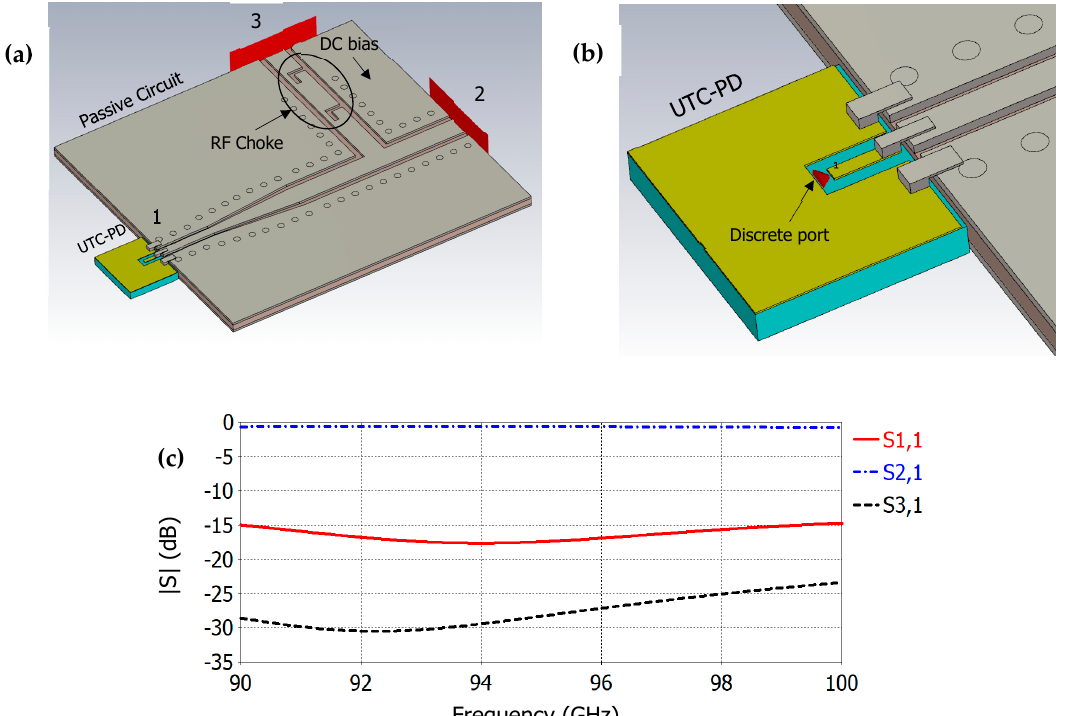
Figure 2. ( a ) 3D perspective view of UTC-PD integrated to tripler passive circuit, ( b ) close-up view of UTC-PD 50 Ω coplanar structure excited by a discrete port providing 100 GHz LO signal and ( c ) simulated frequency response |S|.